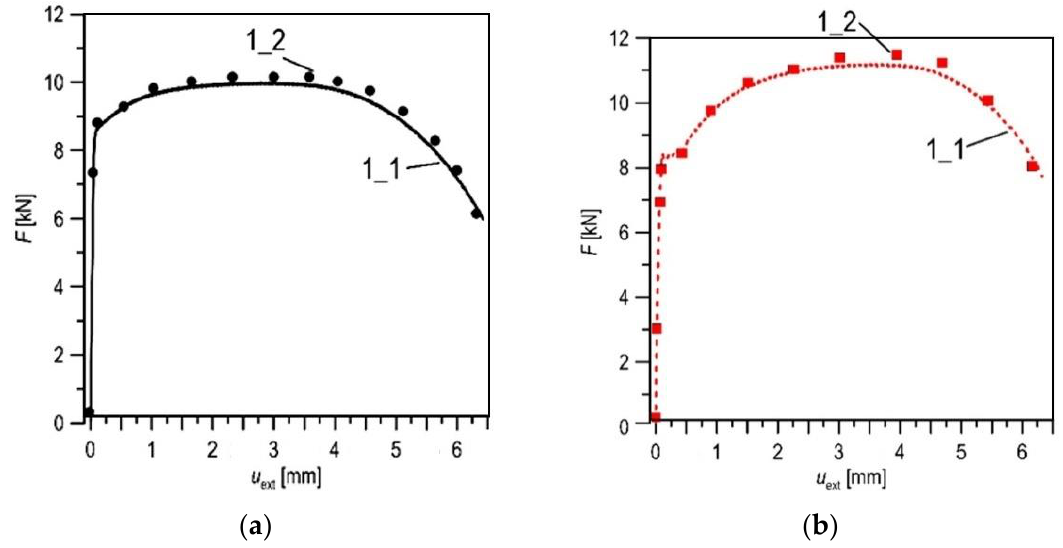
Figure 7. The comparison of the experimental (1_1) and numerical (1_2) force-elongation data for the X52 steel in the as-received state ( a ) and after 30 years of service ( b ).